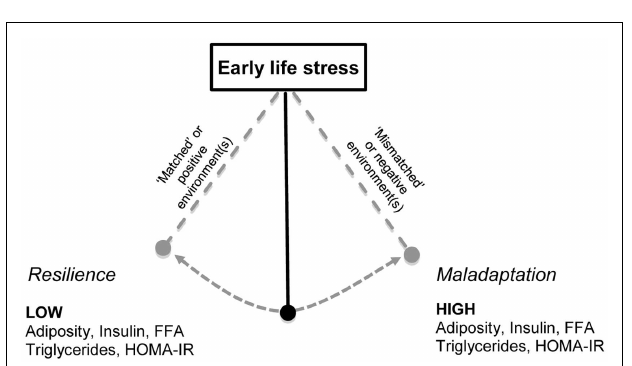
FIGURE 2 |The combination of early-life stress exposure with altered later environment may determine metabolic outcomes . Early-life stress (ELS) exposure during gestation or the postnatal period is hypothesized to influence an offspring’s response to later environments (85, 87).This programing occurs in an attempt to facilitate habituation and resilience to future similar situations. Offspring exposed to environments that do not differ to that to which they were exposed during early life, i.e., “matched” or positive environments, such as exposure to exercise have been shown to adapt and demonstrate resilience (74, 114, 131, 132). Conversely, exposure to a negative environment, i.e., “mismatched,” such as a sub-optimal diet (131, 132, 134) or chronic stress following ELS may lead to maladaptation, and metabolic deficits, with increased levels of triglycerides, free fatty acids, adiposity, and insulin resistance as measured by HOMA-IR. Thus, there is a pendulum of vulnerability and the trajectory following ELS is influenced by the later life